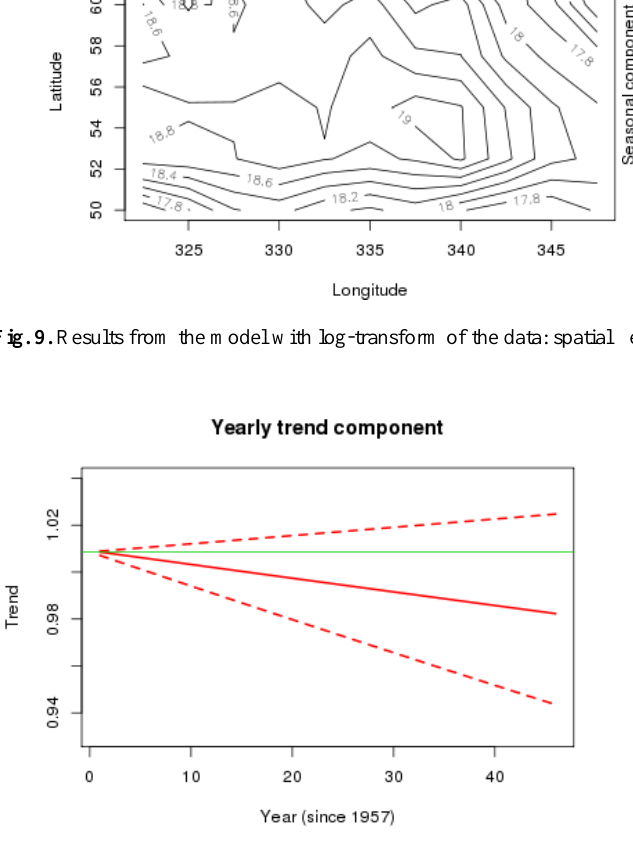
Fig. 10. The estimated trend factor for the log-transformed data, with 90% credible interval